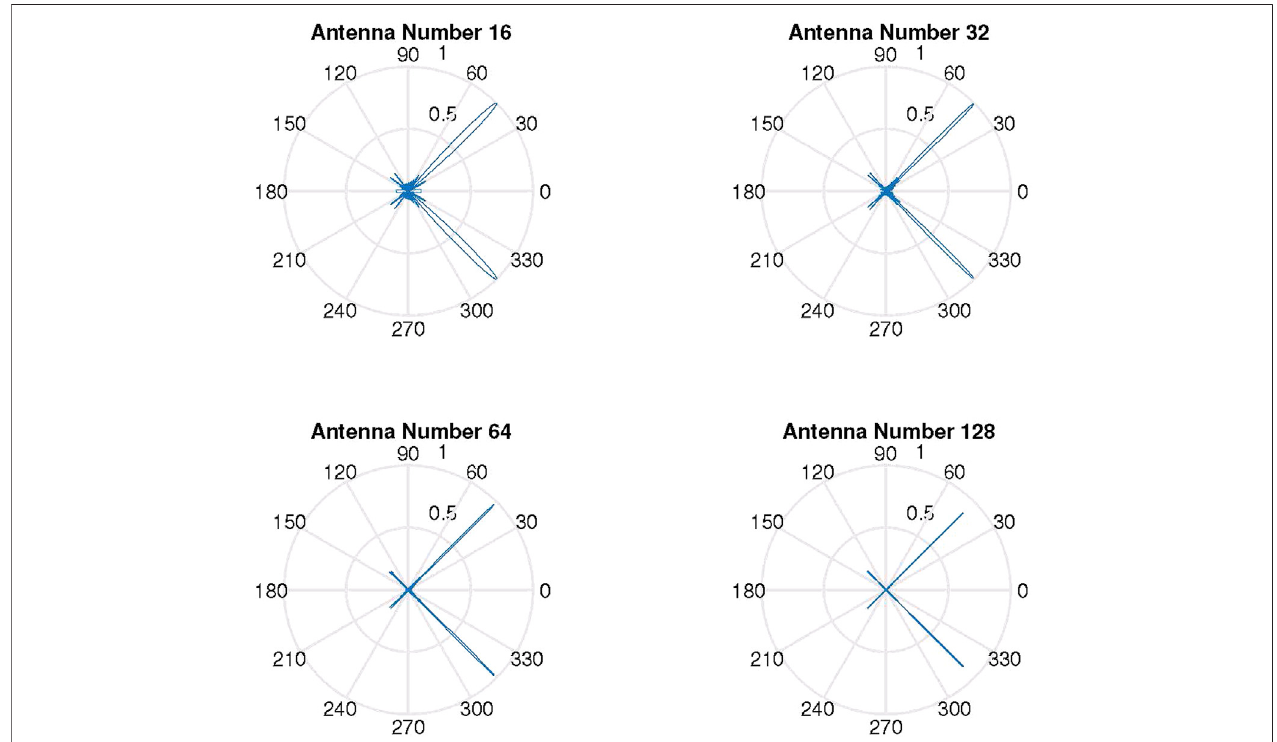
FIGURE 2 | Fixed AOA and gain pattern of the ULA equipped with different number of antennas.